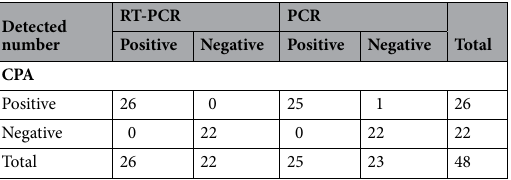
Table 2. Detection results for cell cultures inoculated with clinical plasma with S/P > 0.2.